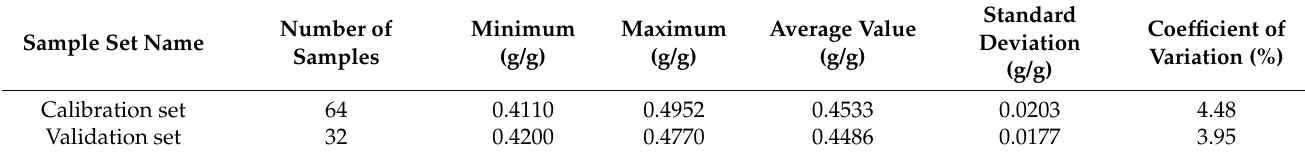
Table 2. Statistical table for experimental sample validation set and calibration set carbon